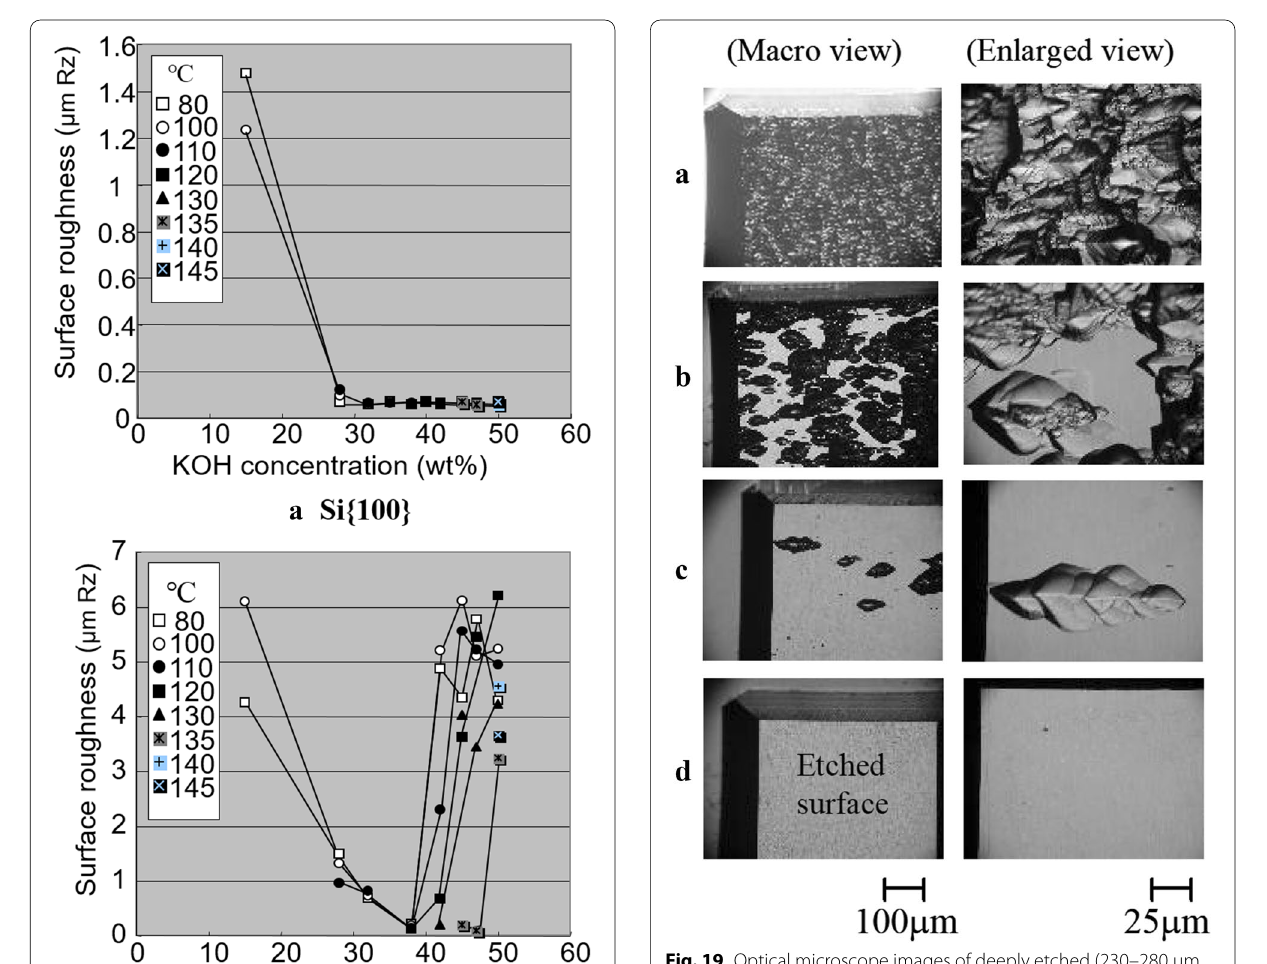
Fig. 19 Optical microscope images of deeply etched (230–280 μm deep) Si{110} surfaces using 45 wt% KOH solution at a 115 °C, b 125 °C, c 130 °C, d 135 °C. A smooth surface without hillocks is obtained at 135 °C [18], © 2004,